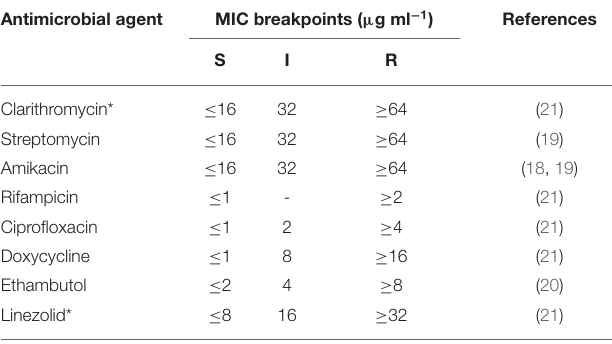
TABLE 2 | Antimicrobial agents tested and proposed MIC breakpoints for